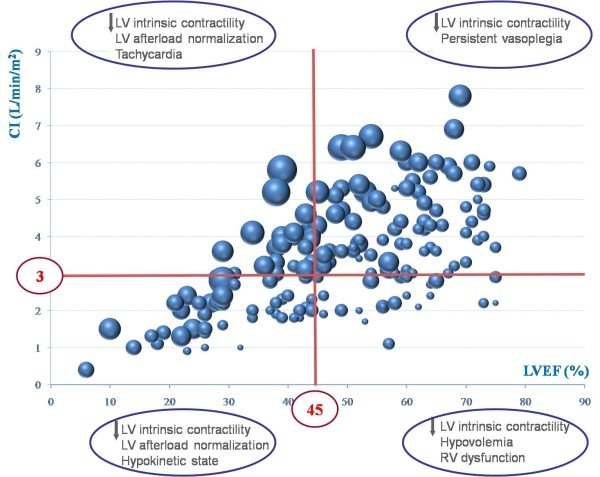
Relationship between left ventricular (LV) ejection fraction (x axis) and cardiac index (y axis) in 183 patients with septic shock who underwent echocardiography. Providing that depressed LV intrinsic contractility is constant, the relation may be separated into four parts according to systemic vascular resistance, volemia, and right ventricular (RV) function. Size of the circles is related to LV end-diastolic volume, from 35 for the smallest to 135 ml for the biggest.